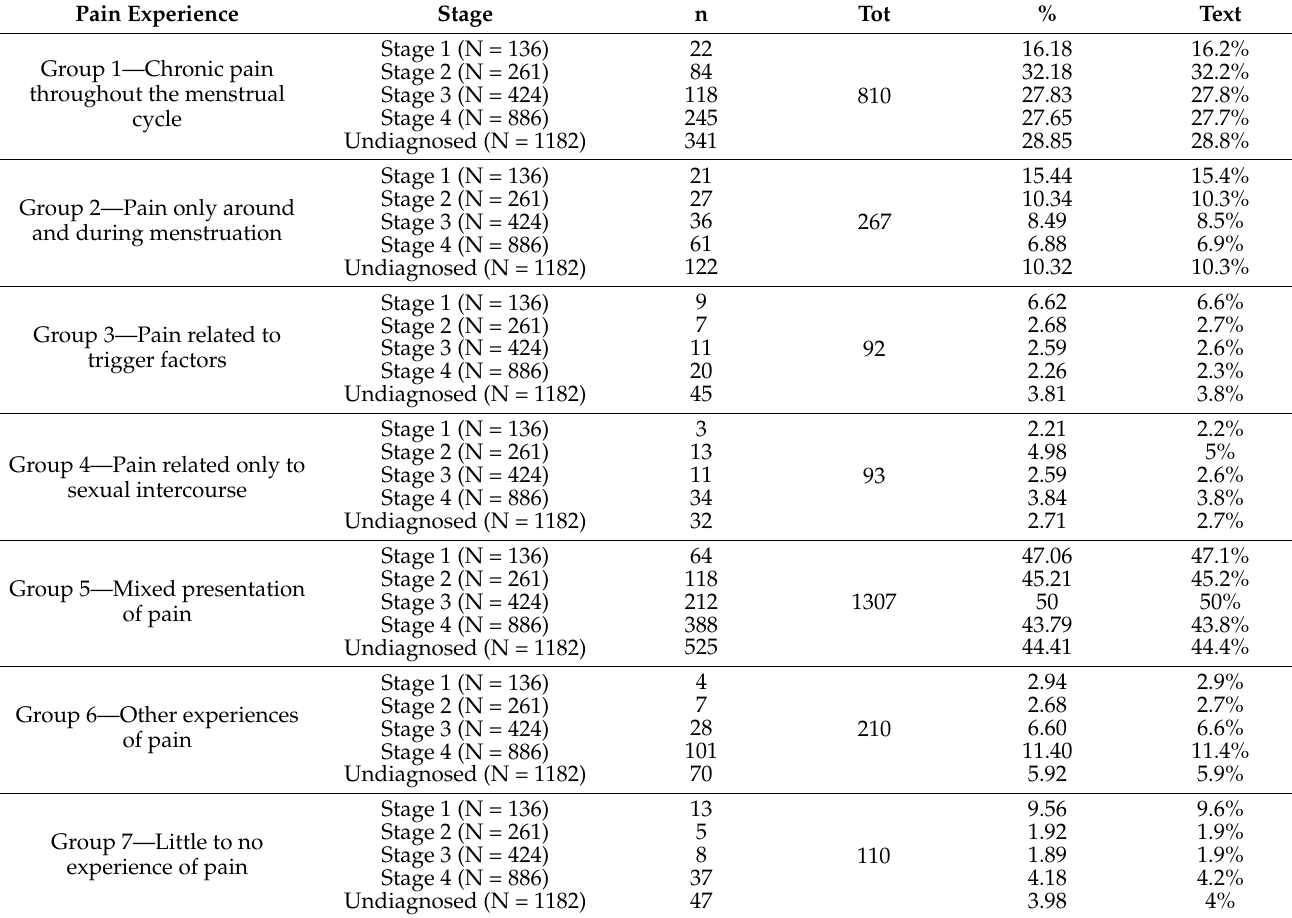
Table 3. Pain experiences related to stage by participants at the time of completing the